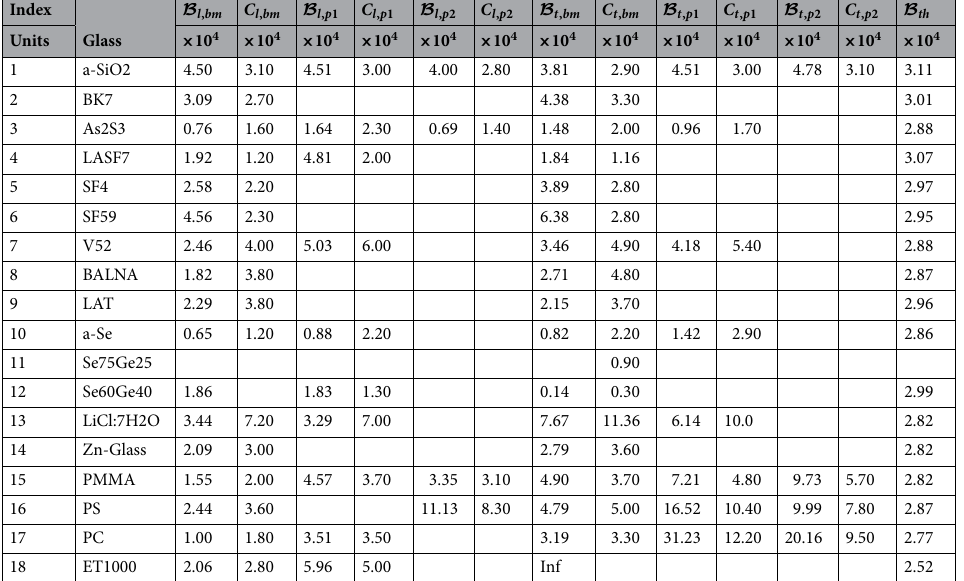
M Table 1. Comparison of theoretical and experimental values of internal friction for 18 glasses with M 1 : = l , t are displayed in odd numbered columns Here the theoretcial result from Eq. (47) labelled as B a , xx , with a ≡ M for M 1 . The 2nd subscript xx refers to the particular experiment used to obtain required parameters in = bm , p 1, p 2 for data from 35 , xx p 1 for accoustic data from 1 , xx p 2 for flexural data from 1 ). Eq. (47): xx ≡ ≡ ≡ The values used for M 1 , c l , c t to obtain B a , xx are given in Table 2, with experimental data for C a given in adjacent even-numbered columns. The last column gives our theoretical prediction from Eq.